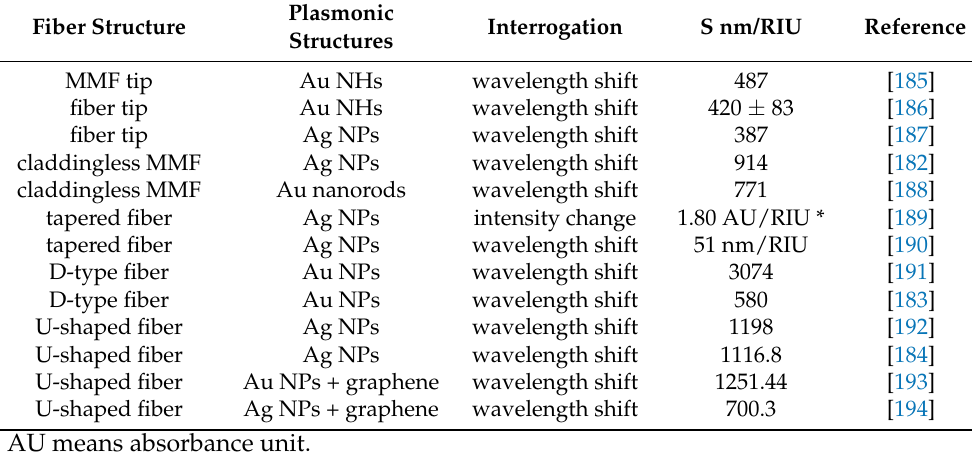
Table 1. Summary of the experimental performances for fiber-LSPR RI sensors.